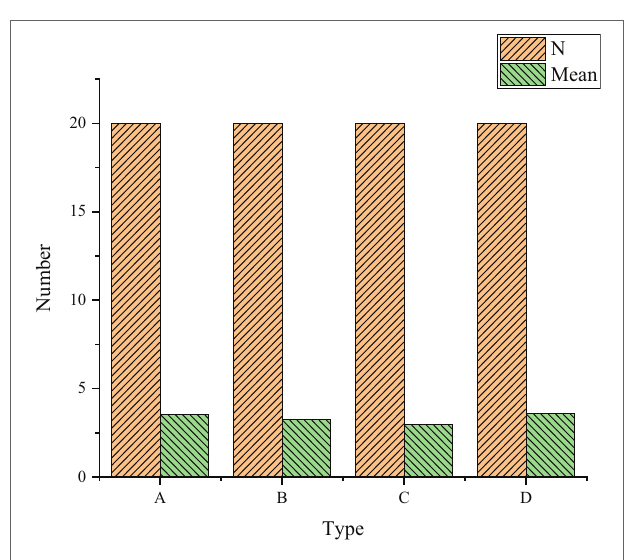
FIGURE 10 | Descriptive statistical results of English anxiety types—A: classroom progress anxiety; B: classroom oral anxiety; C: evaluation anxiety; D: oral